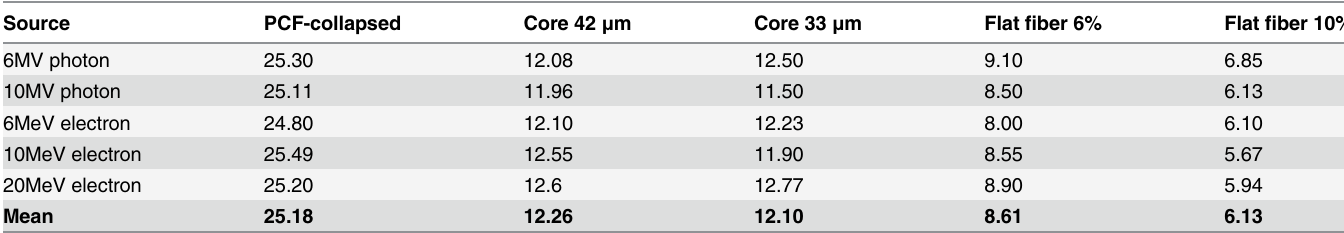
Table 4. The mean sensitivity of the studied fibres.